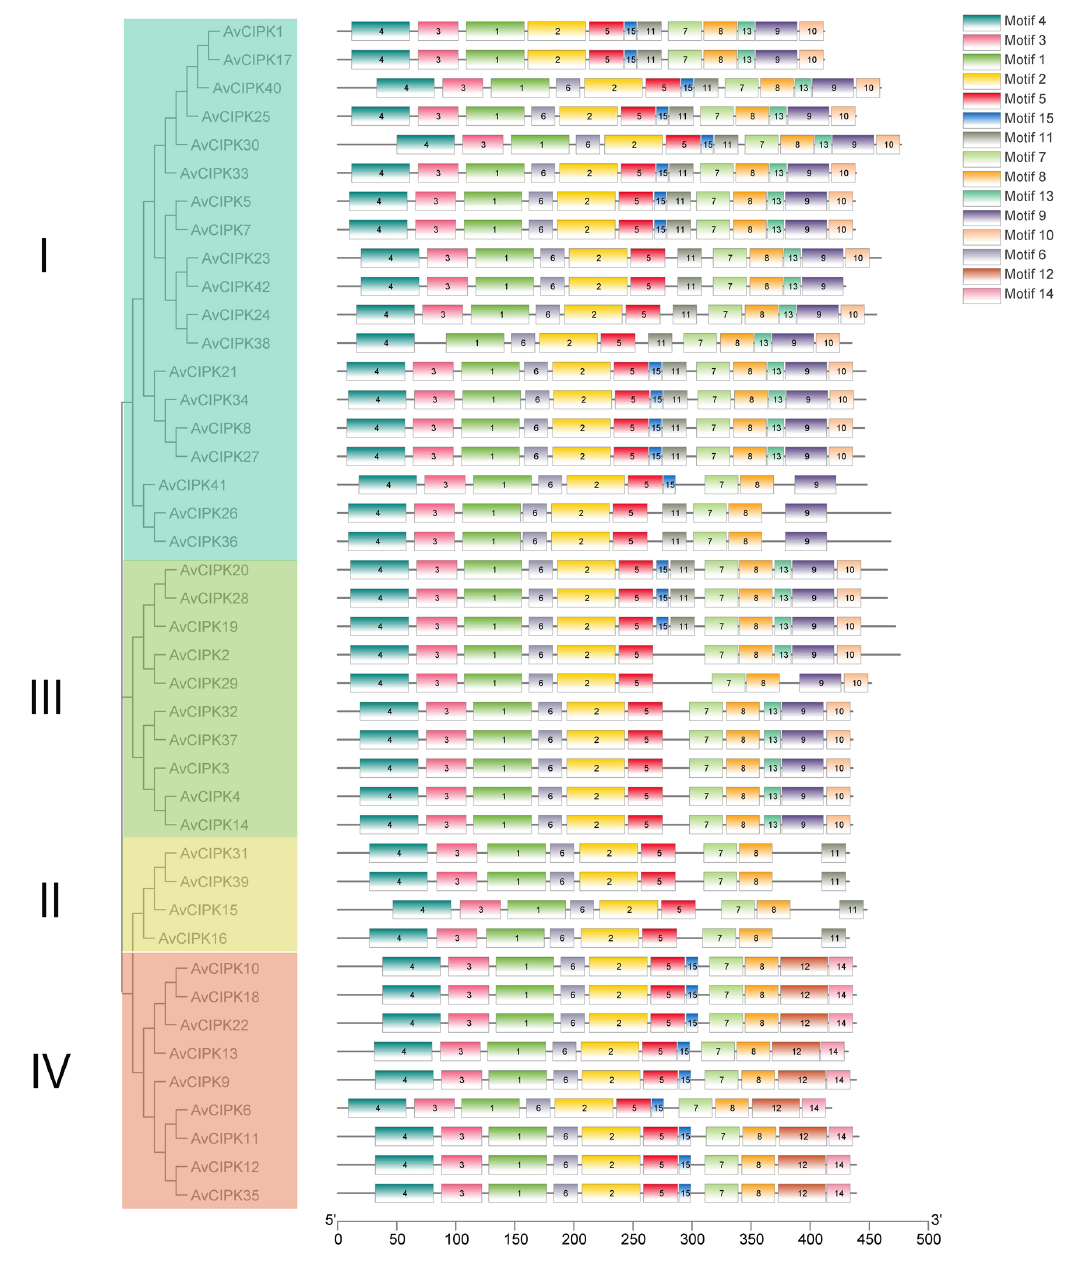
Figure 2. Analysis of phylogenetic relationships and conserved motifs of AvCIPK proteins. The phylogenetic groups and conserved motifs are presented in different colors. I–IV represent the different